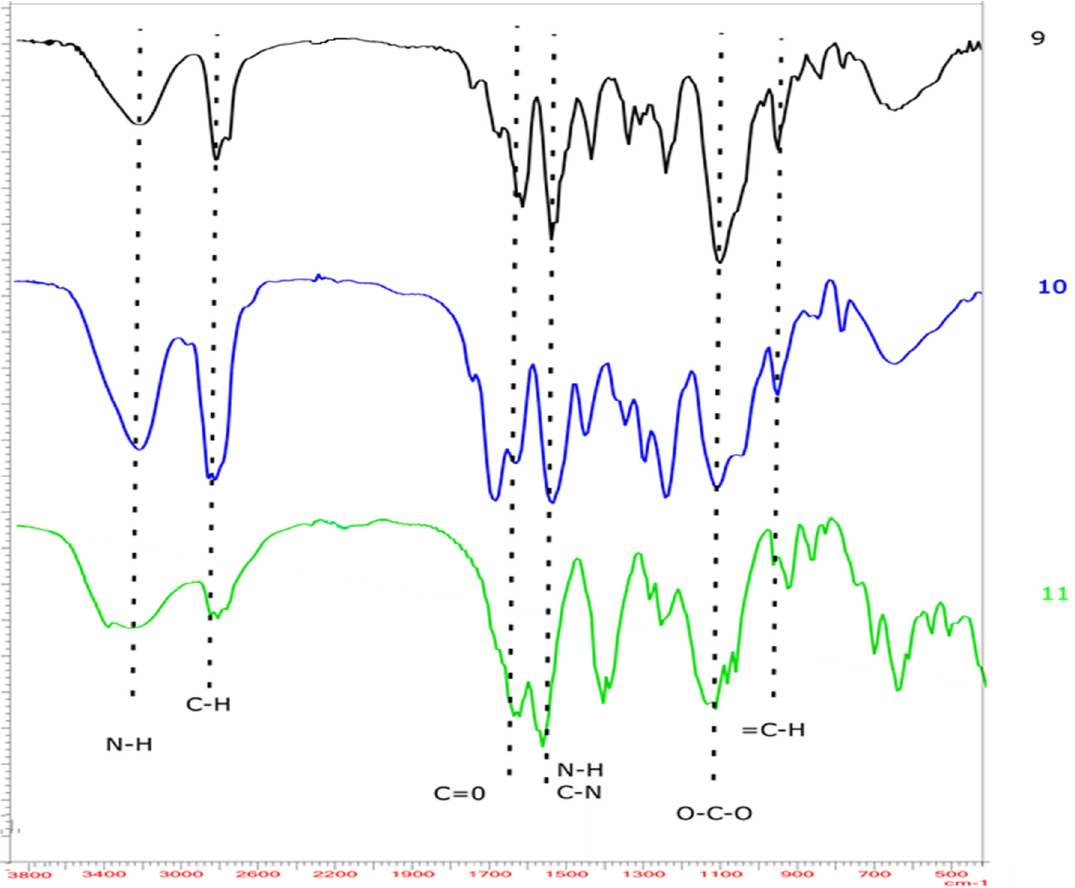
Figure 1. FT-IR spectra of the products ( 9–11 ).